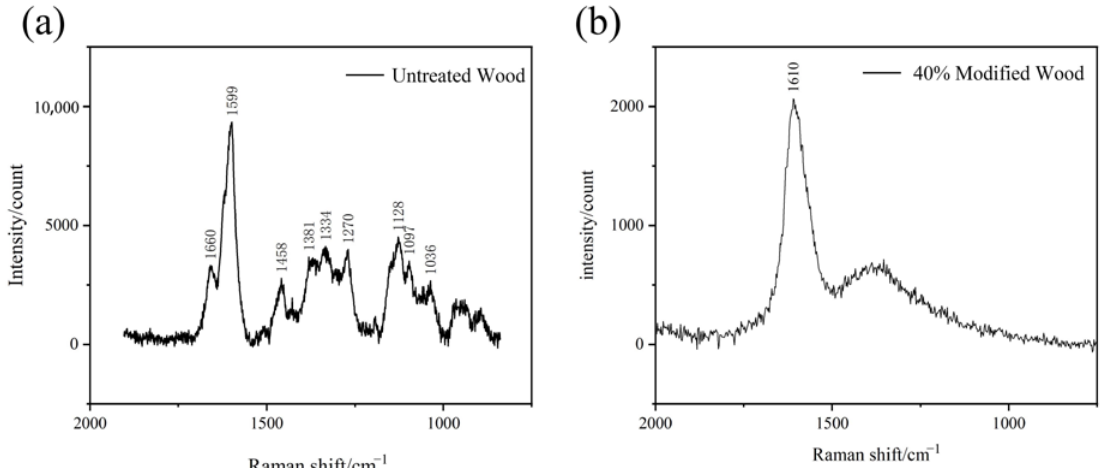
Figure 7. Raman spectrum of tracheid wall before FA treatment ( a ) and after FA treatment ( b ). Background fluorescence was obvious in furfurylated sample ( b ). The numbers in the figure are the characteristic peak values of Raman spectrum.